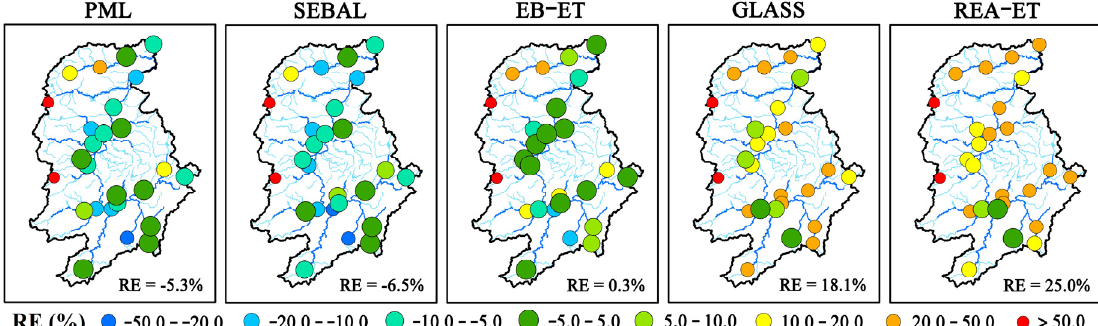
Figure 4. The relative error (RE) of each sub-basin between ET datasets and the annual average water balance-based ET. The results of the basin-average ET comparison are given at the bottom right of each picture.